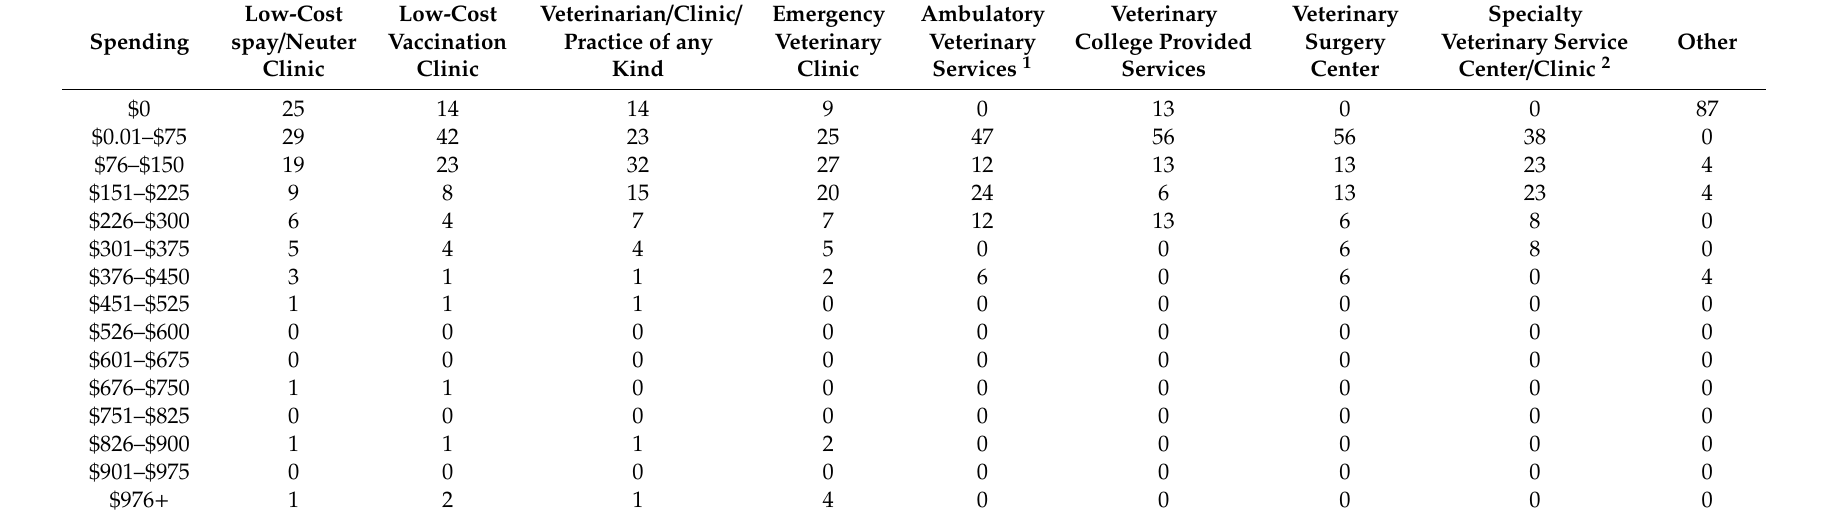
Table A9. Cat owner spending on veterinary related items, percentage of cat (n = 332) owners, by income